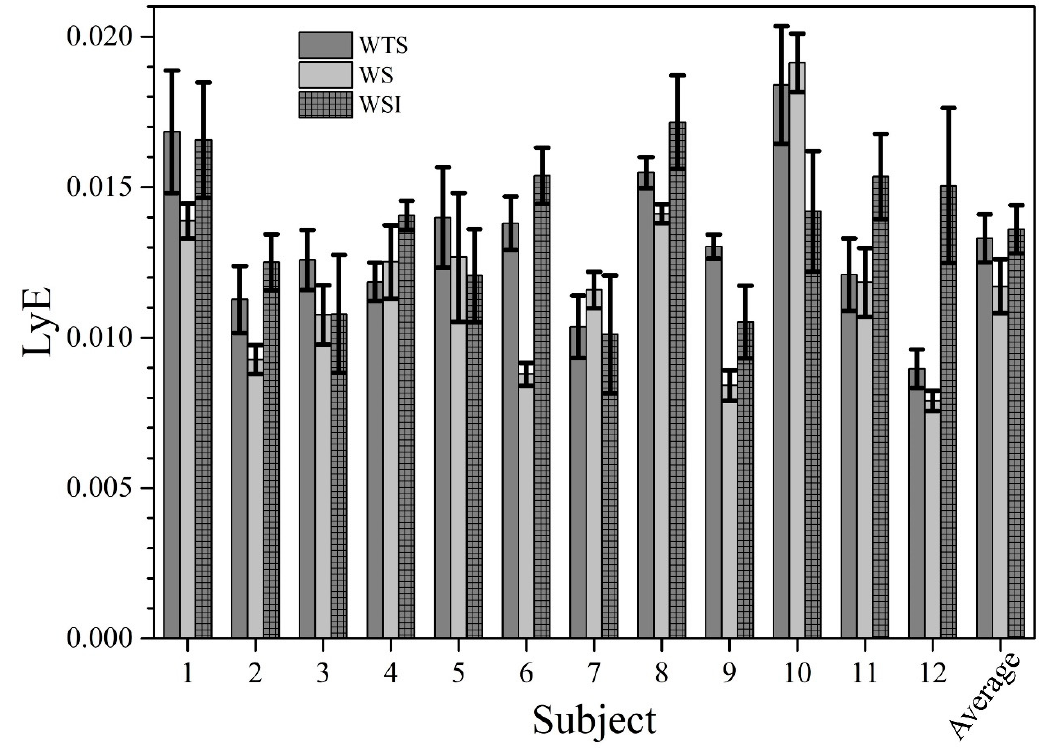
Figure 5. Maximum Lyapunov exponents (LyEs) calculated for each subject in each investigated walking condition. LyE values are measured in (stride cycles) − 1 .